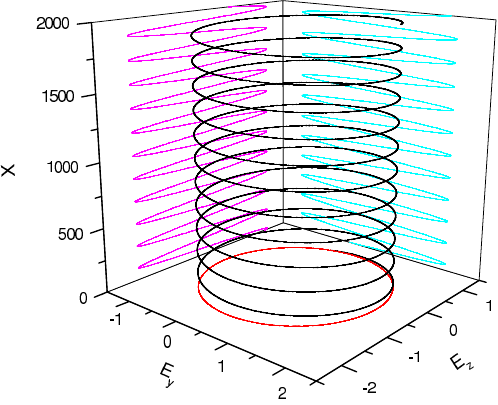
Fig. 5. FFT spectrum of the deformed sinusoidal E x solitary struc- tures.